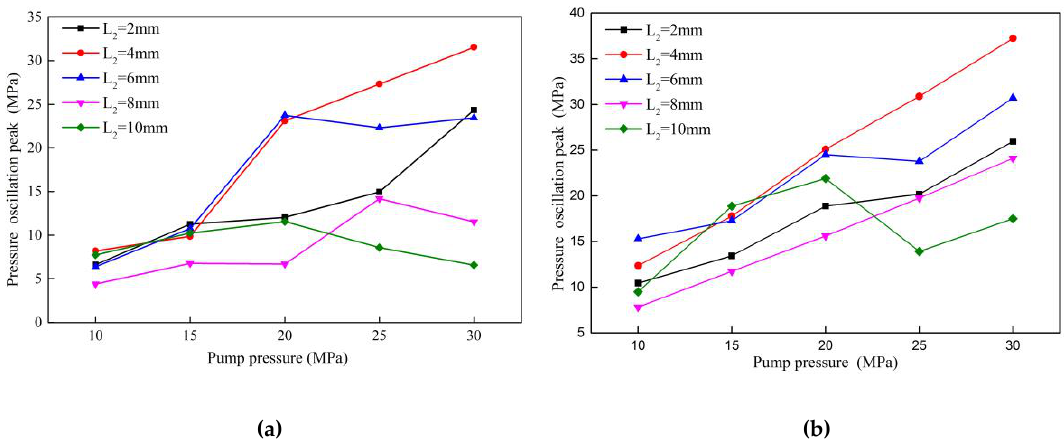
Figure 13. Performance of different L 2 nozzles under each pump pressure. a. maximal jet pressure pulsation amplitudes of different L 2 nozzles. b. maximal jet peak pressures of different L 2 nozzles at each pump pressure.